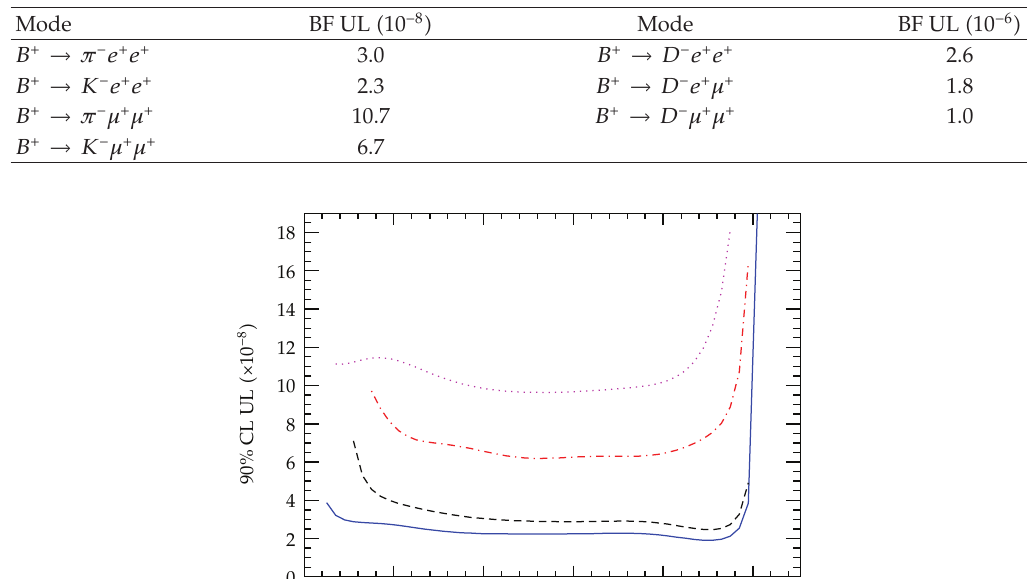
Table 3: Results of lepton number violation searches performed by the BABAR (cid:2) left column (cid:3) and Belle Collaborations (cid:2) right column (cid:3) . The limits are given at 90% confidence level.